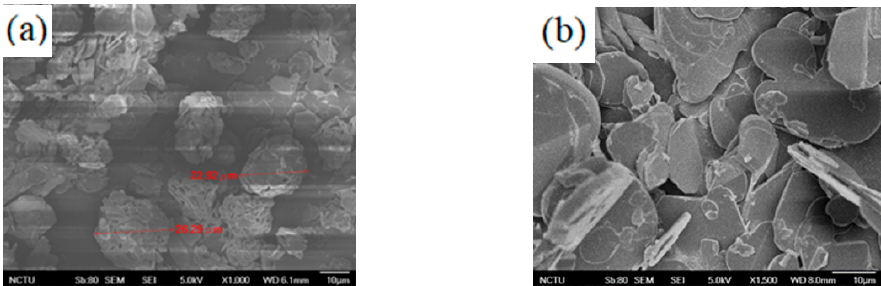
Figure 7. SEM images of fracture surfaces of ( a ) TMBPE/s-BN (60vol%) ( b ) TMBPE/f-BN (60vol%).